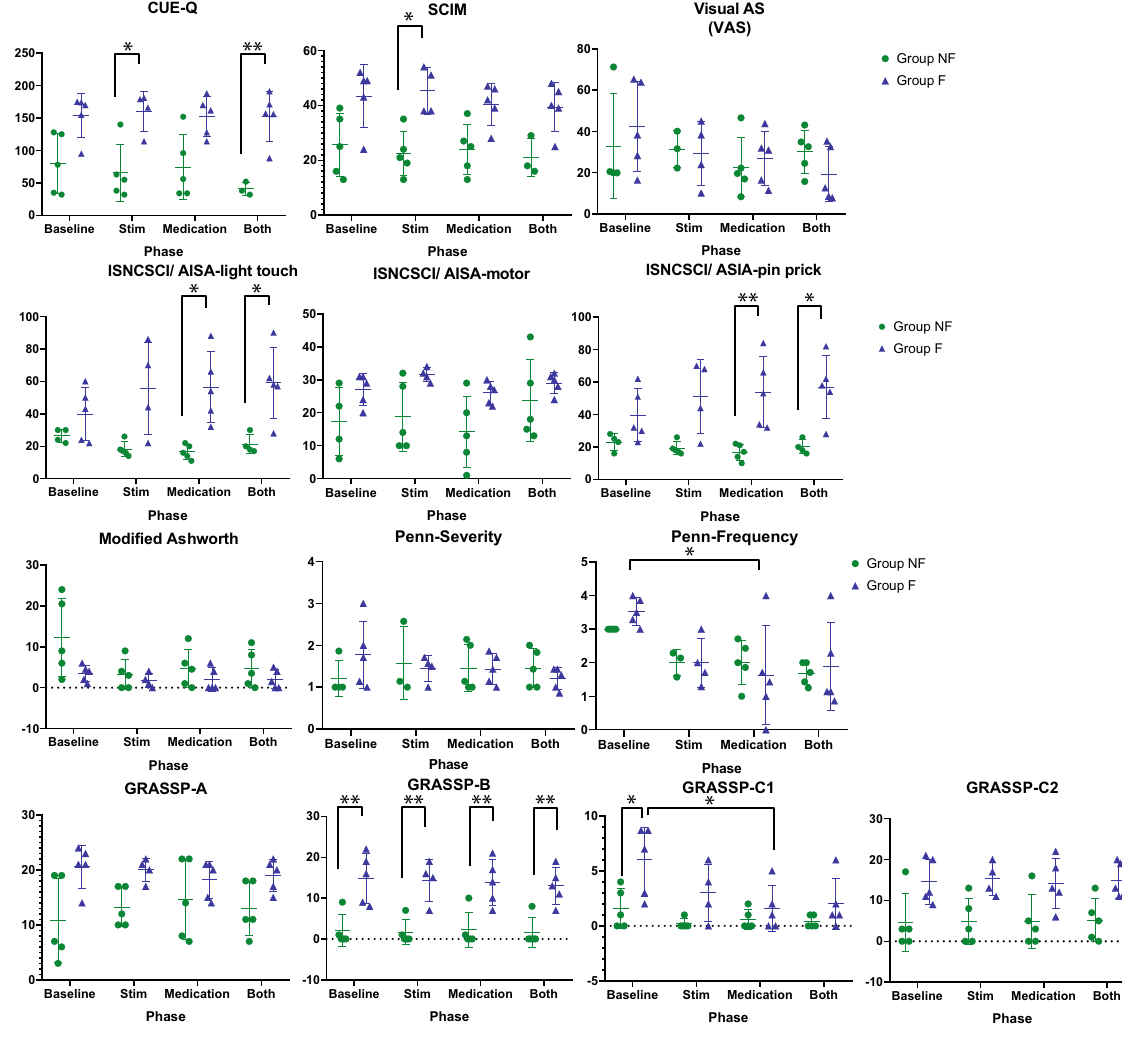
Figure 7. Results of the functional assessments. Standardized functional measures recorded at the end of each phase including baseline (BL), stimulation only (Stim), medication only (Med), and combined stimulation and medication (Both) for major functional test including AIS measurement for motor and sensory function, the Modified Ashworth scale of muscle tone, the self-assessed Penn spasm scale for frequency and severity of spasticity, and the self-assessed VAS as measure of spasticity. Treatment order is listed in the same order for each subject and does not reflect the actual order of treatment that each subject received. The number of asterisks indicates the threshold significance level detected by the two-way ANOVA; *: P < 0.05, **: P < 0.01, and ***: P < 0.001. The means and the standard deviation (SD) are